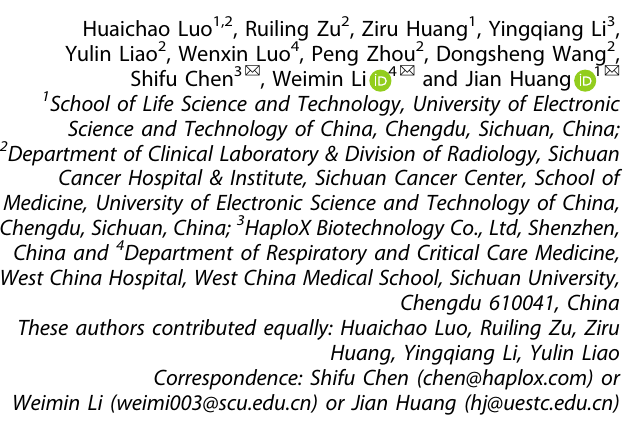
Fig. 1 The study design and main results. a In this prospective cohort study, patients suspected of having indeterminate pulmonary nodules were enrolled and their CT information was recorded. Blood samples were collected and stored prior to surgery. TCR sequencing was performed and analyzed. b Venn diagrams were used to identify clones just existing in the malignant group. common motif of enriched CDR3 β aaSeqs is displayed. c The top 10,000 TCR clones are shown by Packed circles for the benign and stage I groups (one circle represents one clone; circle size represents clonal fraction). d The relationship between the clone types and the clinical characteristics of the benign and malignant groups is demonstrated. e A boxplot to illustrate the difference between benign and malignant clones for small-type and hyperexpanded-type clone types. f Comparison of TCR repertoire diversity between benign and malignant groups using boxplots. g Comparison of the diagnostic value of TCR repertoire diversity with previous models using ROC curves. h Boxplot showing the difference in Shannon index between benign and malignant groups in the GGN group and the non-GGN group separately. i Random forest and information gain methods were used to select signi fi cant features for the TCRnodseek model. j The predicted value calculated by TCRnodseek in the discovery and validation groups are presented as boxplots and ROC curves ( k ). l the ROCs of the models with and without TCR features. m the relationship between TCRnodseek predicated value and various clinical characteristics. n A Sankey diagram illustrating the misclassi fi cation of TCRnodseek and experts in comparison with pathology results (Thoracic_doc, the results determined by Thoracic doctors; CT_doc, the results determined by Radiology doctors; TCRnodseek_youden, the results determined by TCRnodseek with youden cutoff). o A bubble plot illustrating the relationship between CT doctors ’ diagnoses, pathology results, and TCRnodseek predicted value (the size of the bubble represents the mean predicted value of TCRnodseek; the color of the bubble represents the number of subjects in the condition). p A waterfall plot showing the TCRnodseek function for nodule sizes < = 20 mm (the X-axis represents the sample id sorted by the predicted value of TCRnodseek; the Y-axis represents the predicted value of TCRnodseek minus the cutoff value). q The diagnostic performance of TCRnodseek in the validation group (the original subjects of ( b ) to ( i ) fi gures are all subjects; the original subjects of ( l ) to ( q ) fi gures are independent validation subjects; GGN ground glass